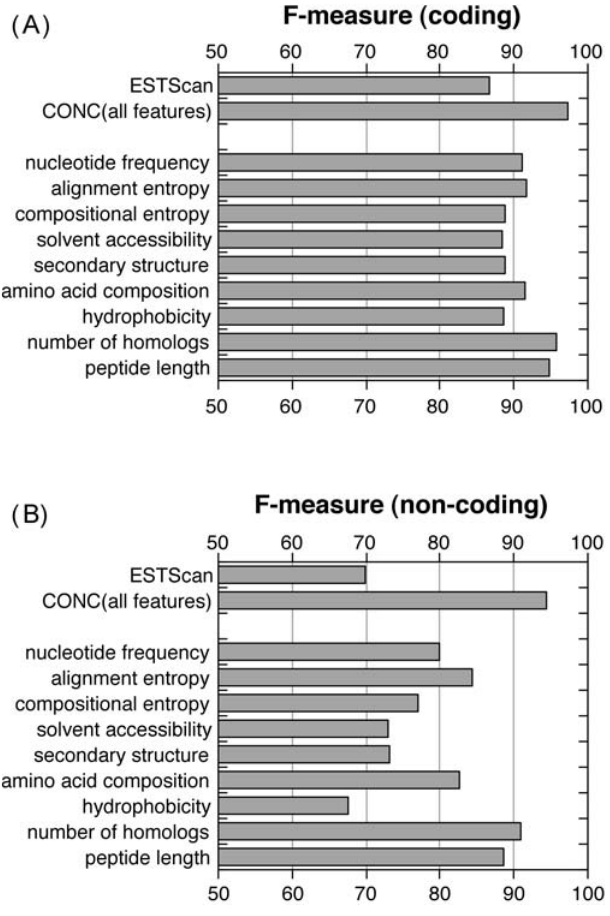
Figure 2. Performance of CONC with Different Input Features F -measures (harmonic mean of specificity and sensitivity; see Materials and Methods) were calculated for different SVMs for both the coding (A) and non-coding (B) predictions. Since the coding set was twice as big as the non-coding set, the percentage of incorrect predictions was bigger for the non-coding set, hence the smaller F -measures. When used individually, input features achieved F -measures of 67.6 to 90.9 on the non-coding set. Combining the features improved the performance to 97.4 for coding and 94.5 for non-coding. In comparison, ESTScan received F -measures of 86.7 and 69.9 for coding and non-coding predictions, respectively. The top-performing features were number of homologs in the protein database and peptide length. DOI: